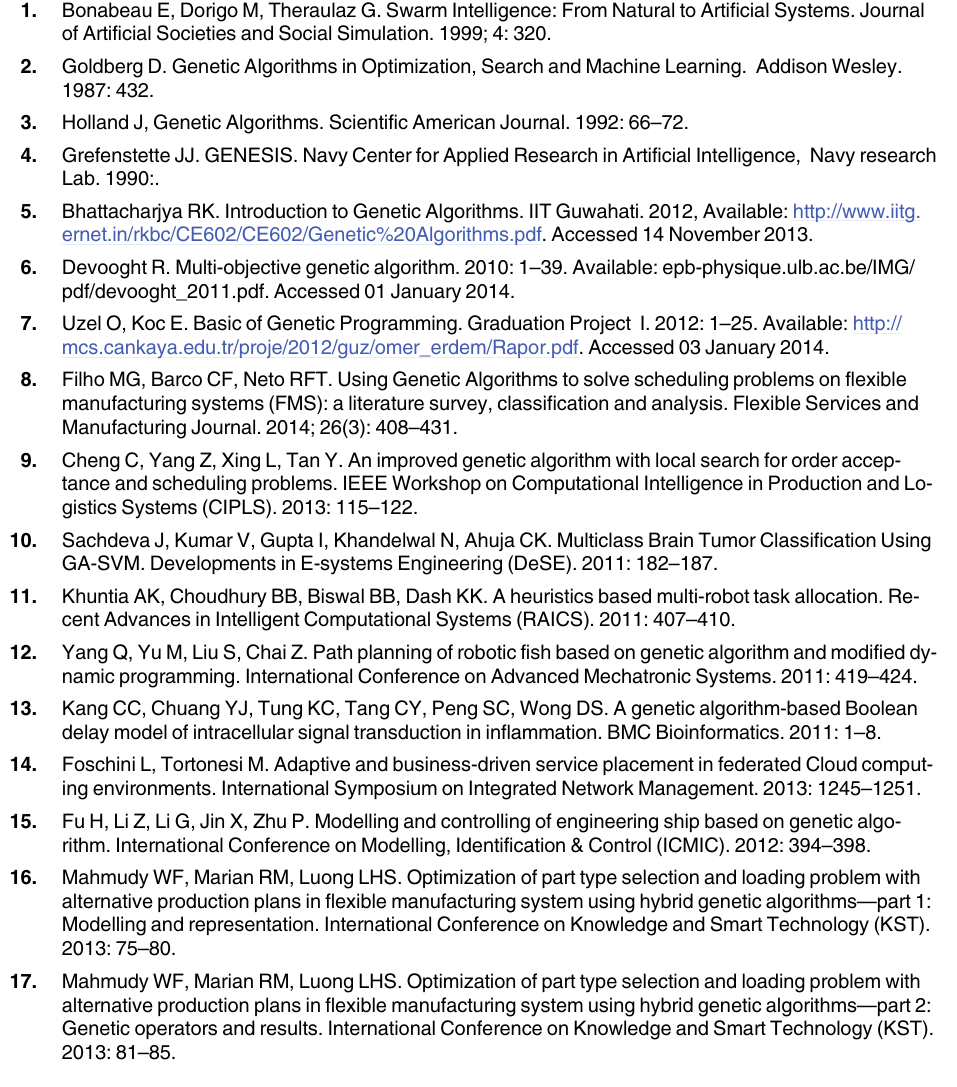
of mean error (Mean ± SD) and time (Seconds) on several Optimization Techniques. Table L. Benchmark Functions Comparison with an offset of mean error (Mean ± SD) and time (Sec- onds) on several Optimization Techniques. Table M. Benchmark Functions Comparison with an offset of mean error (Mean ± SD) and time (Seconds) on several Optimization Techniques. Table N. Comparison of various DE-based algorithms (Mean ±